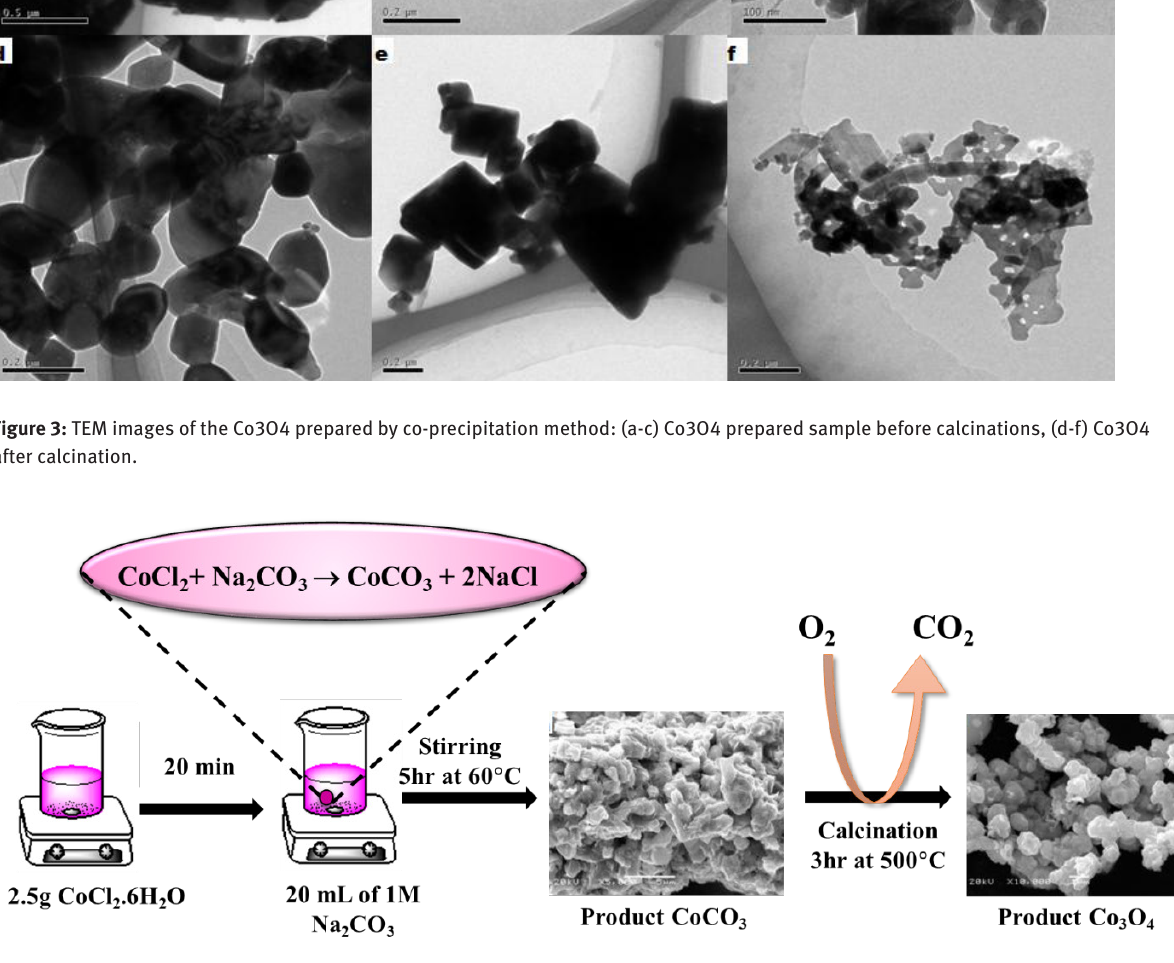
mechanism of AP powder of fine particle size differs that of AP of larger particle size.